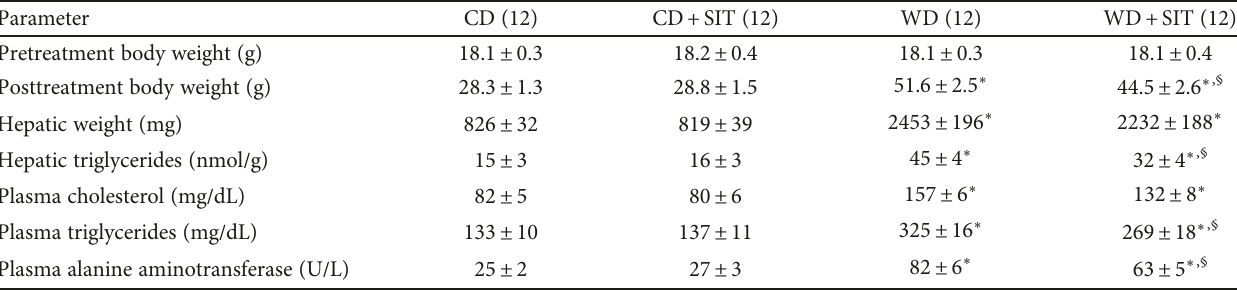
Table 1: Baseline and posttreatment parameters of body weight and plasma metabolic markers in control and WD group mice with or without SIT treatment. Values are mean ± SE. ∗ P < 0 05 compared to the CD or CD +SIT group; § P < 0 05 compared to the WD group. Sample sizes are noted in